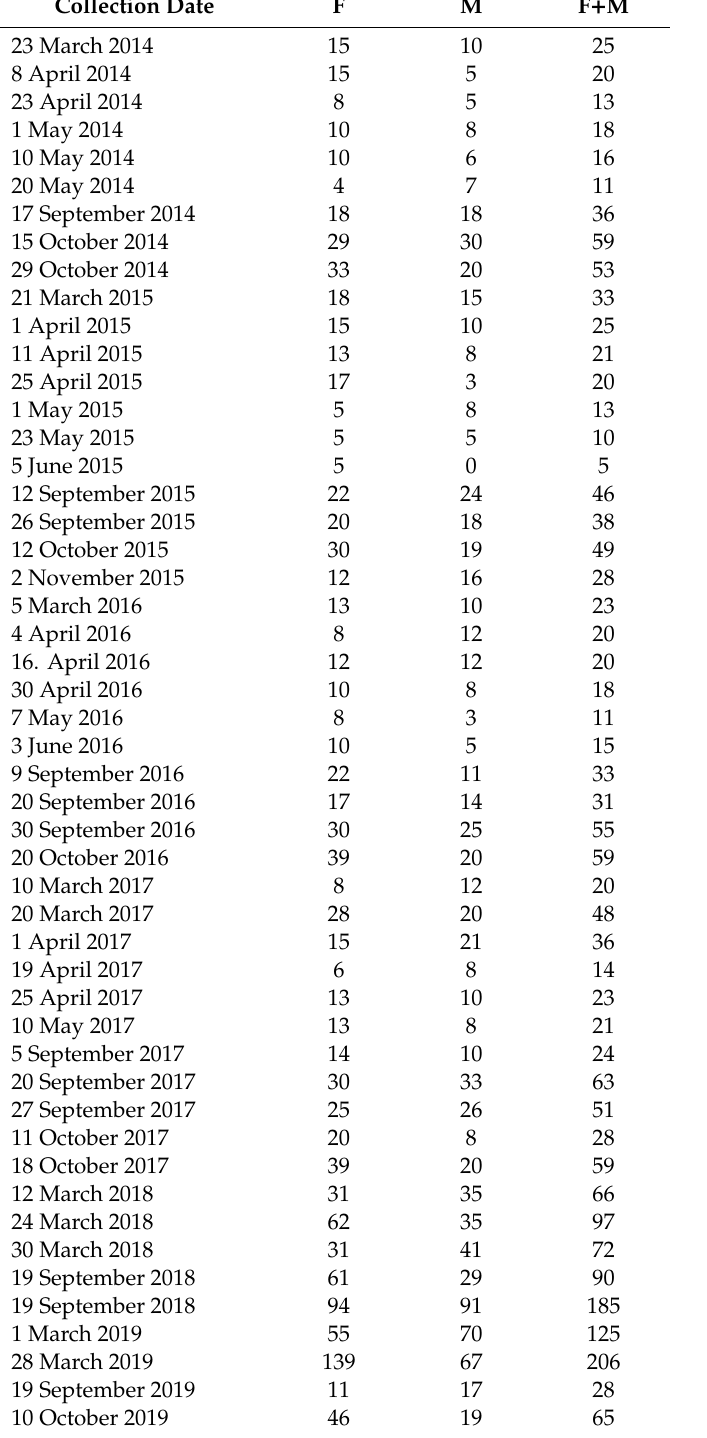
Table A1. Seasonal activity of D. reticulatus ticks in Polesie National Park in 2014–2019 per 100 m 2